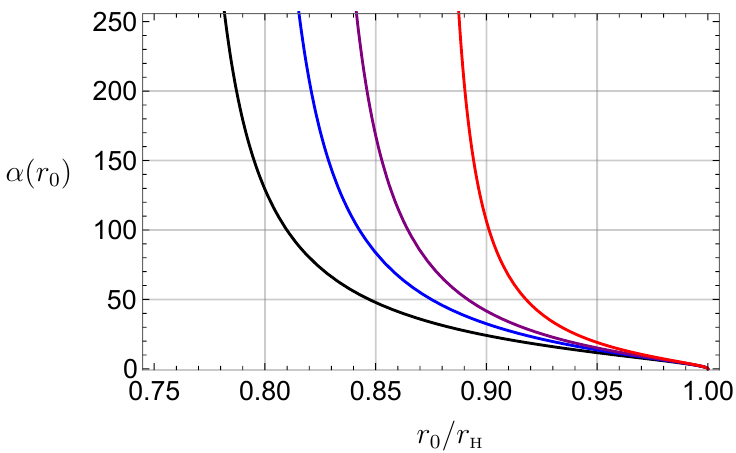
Figure 5 . Shock wave parameter (cid:11) versus the ‘turning point’ r 0 divided by r SYM theory. The curves correspond to a = 0 (black curve), a = 0 : 8 (blue curve), a = 1 (purple curve) and a = 2 (red curve). In all cases we have (cid:12)xed r